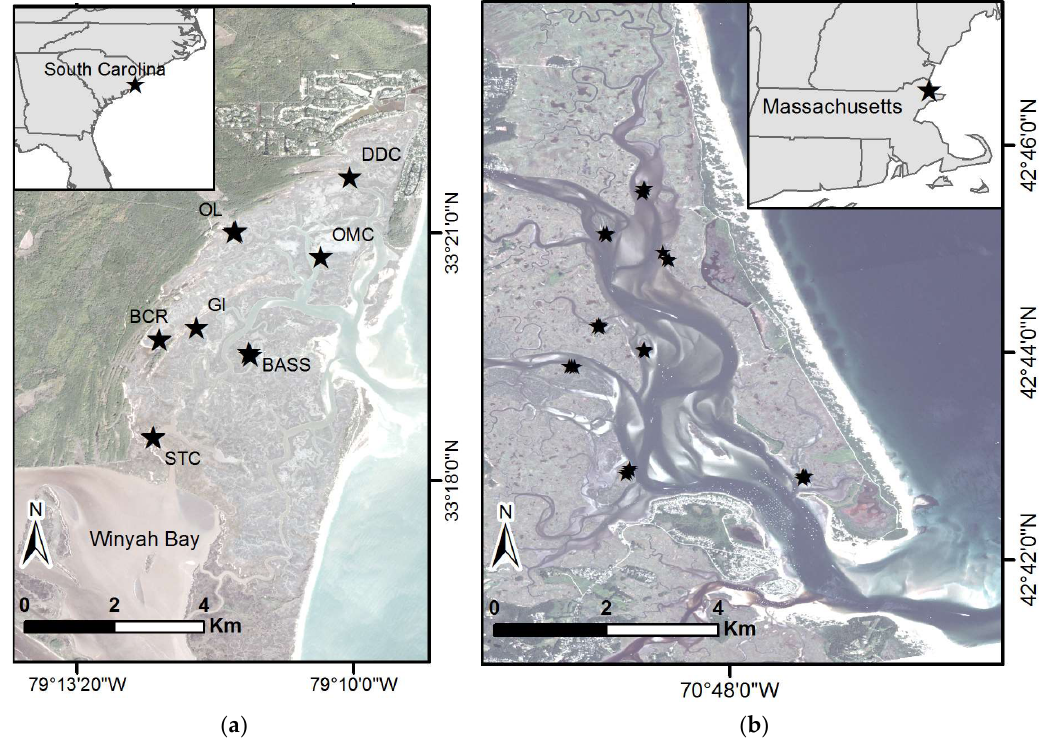
Figure 1. Study areas and sample sites, with stars indicating sample locations. ( a ) North Inlet-Winyah